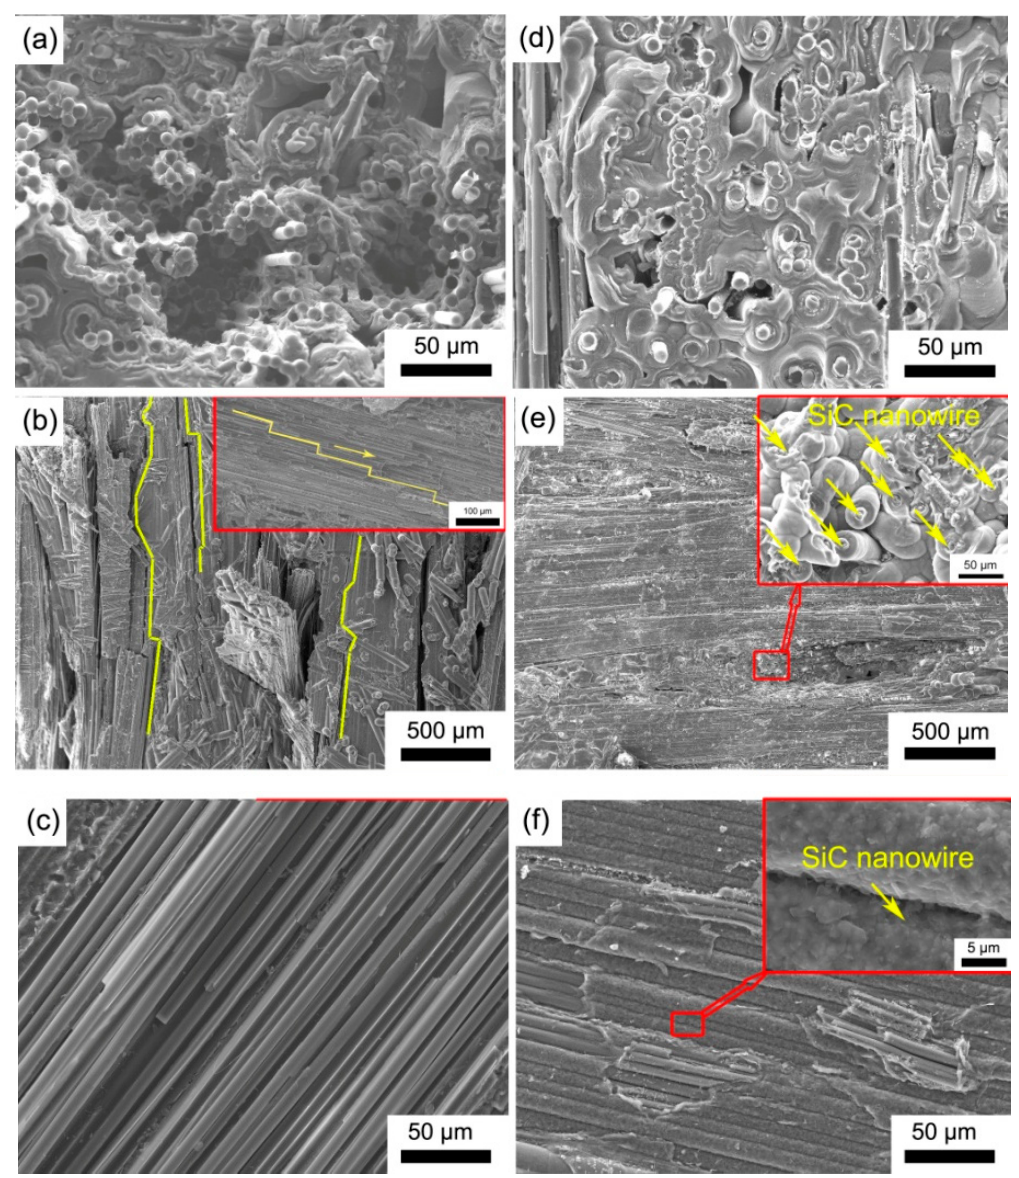
Figure 7. SEM images of compressive fractures and ILSS surfaces for the C/C ( a – c ) and SiCNW-C/C ( d – f ) composites.